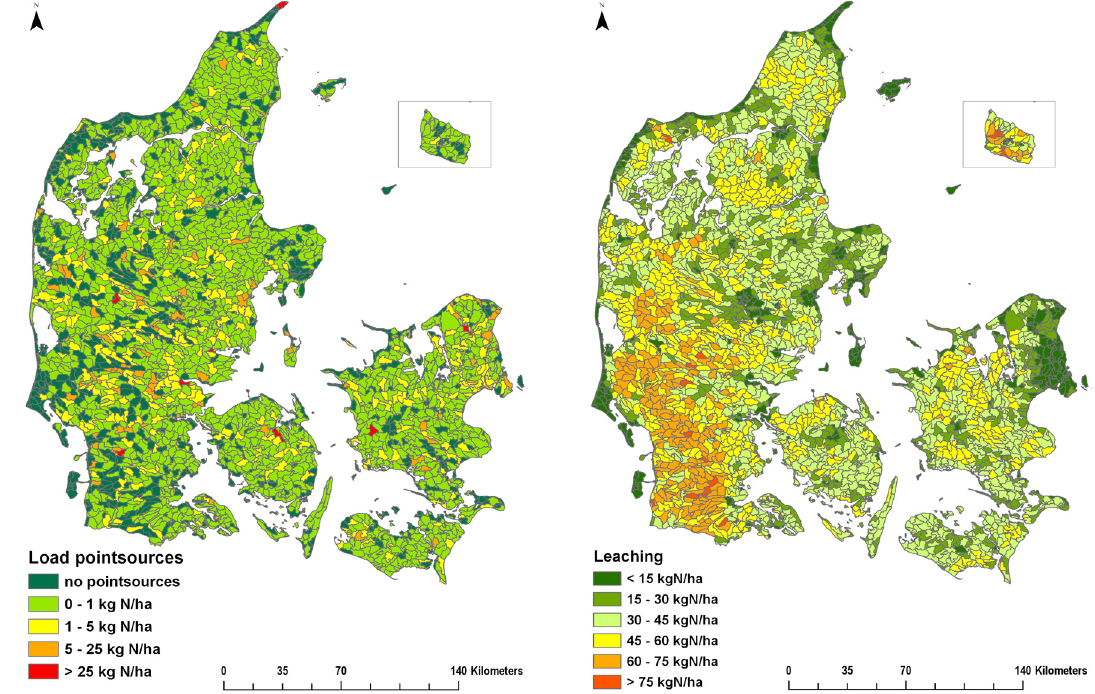
Figure 3. Average annual point source discharges of TN (kg ha − 1 ) in 2010 to 2015 ( left ) and level of N leaching from land to water in 2010 ( right ), for Denmark [7,19,32,37].